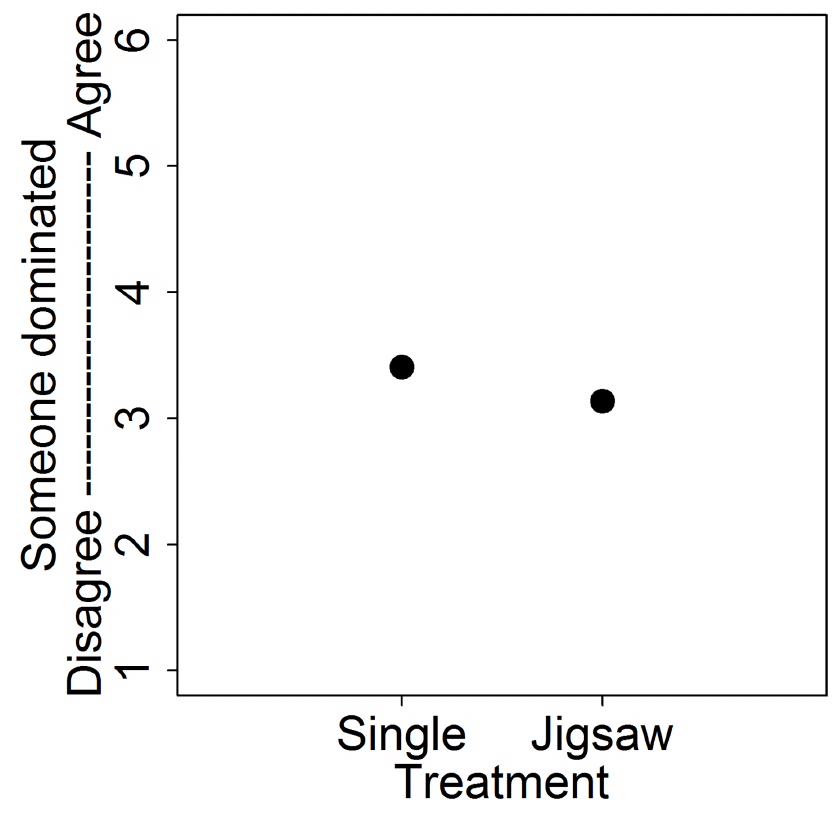
Fig 3. Raw means show that a carefully designed jigsaw in-class activity reduced the dominator report rate compared to a single-group activity. Error bars, which are present but subsumedby the point, indicatestandard error. See Table 2 for final models and